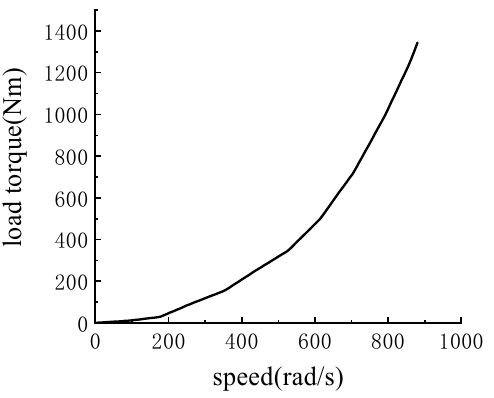
Figure 9. Relationship between load torque and rotational speed.